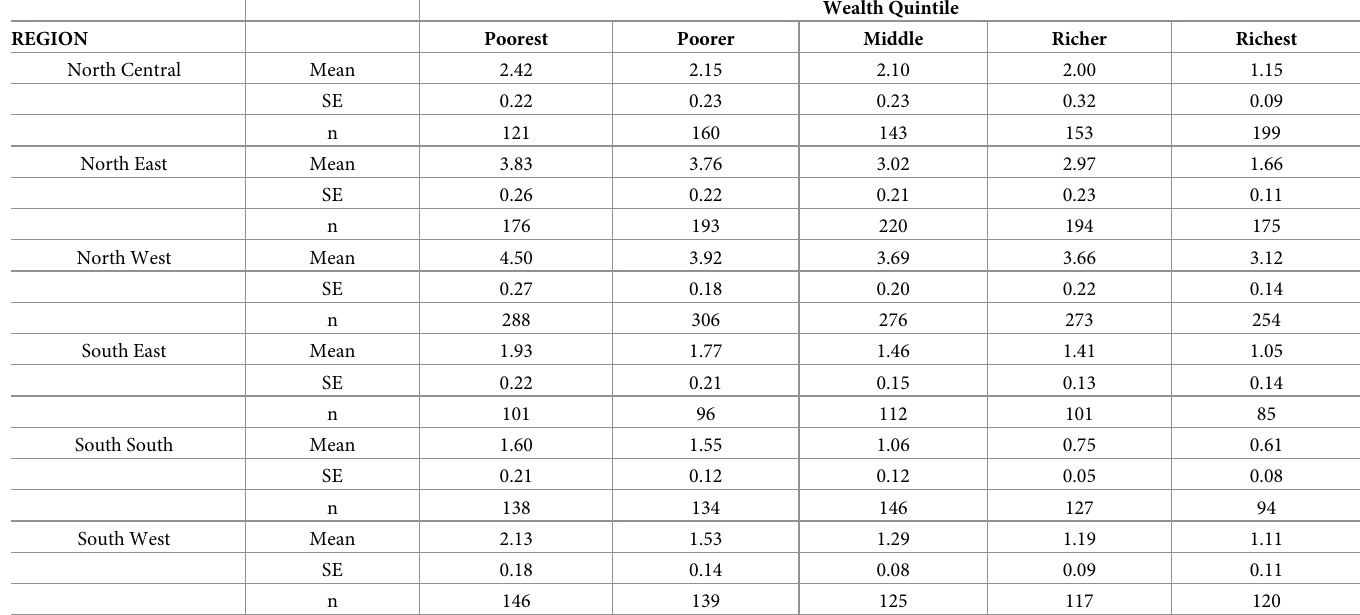
Wealth Quintile